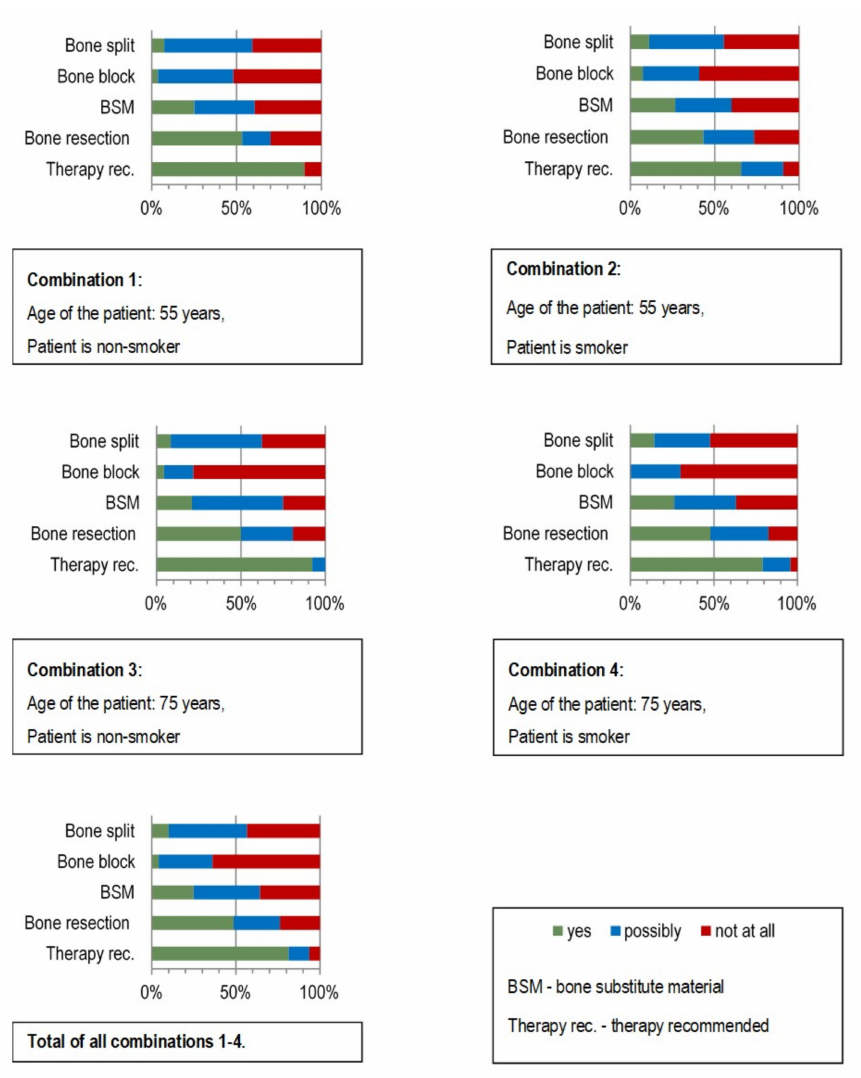
Figure 6. Preferred therapy decisions of the surgeons surveyed for the restoration of the edentulous severely atrophied mandible according to the four different combinations of “radiotherapy” and “anxiety”. Case Vignette